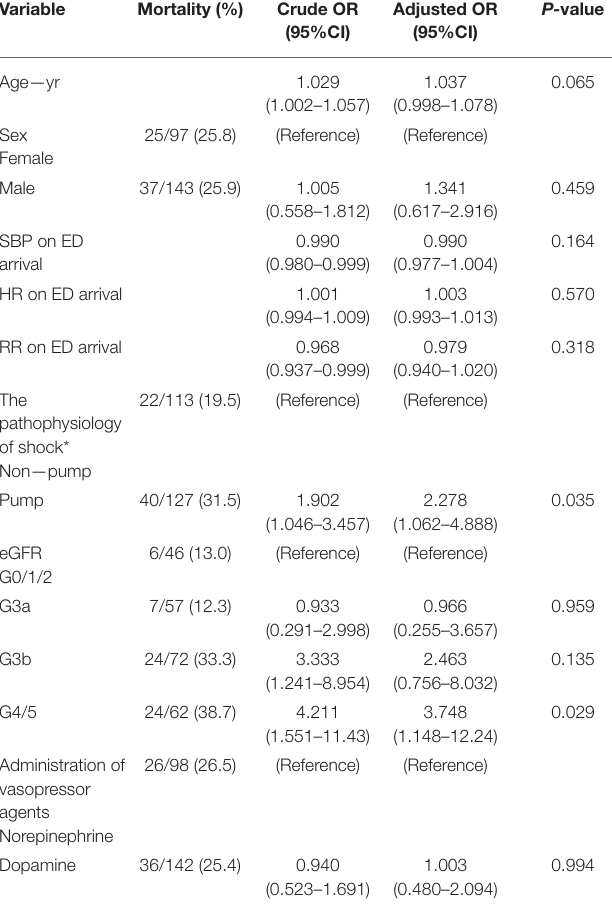
TABLE 2 | In entire study population, factors associating with 30-day mortality after hospital arrival. Variable